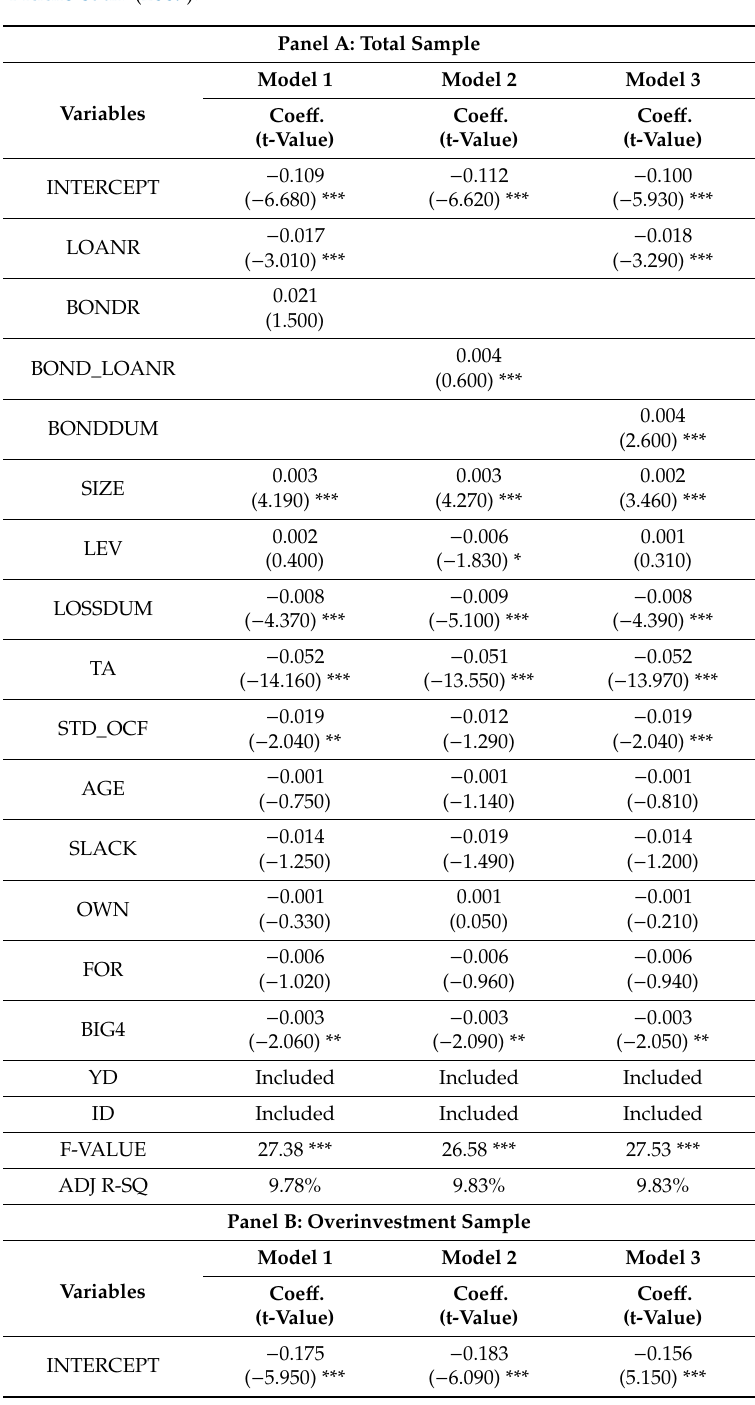
Table 10. Debt origin and investment e ffi ciency: analysis result using the investment e ffi ciency measured as Biddle et al.